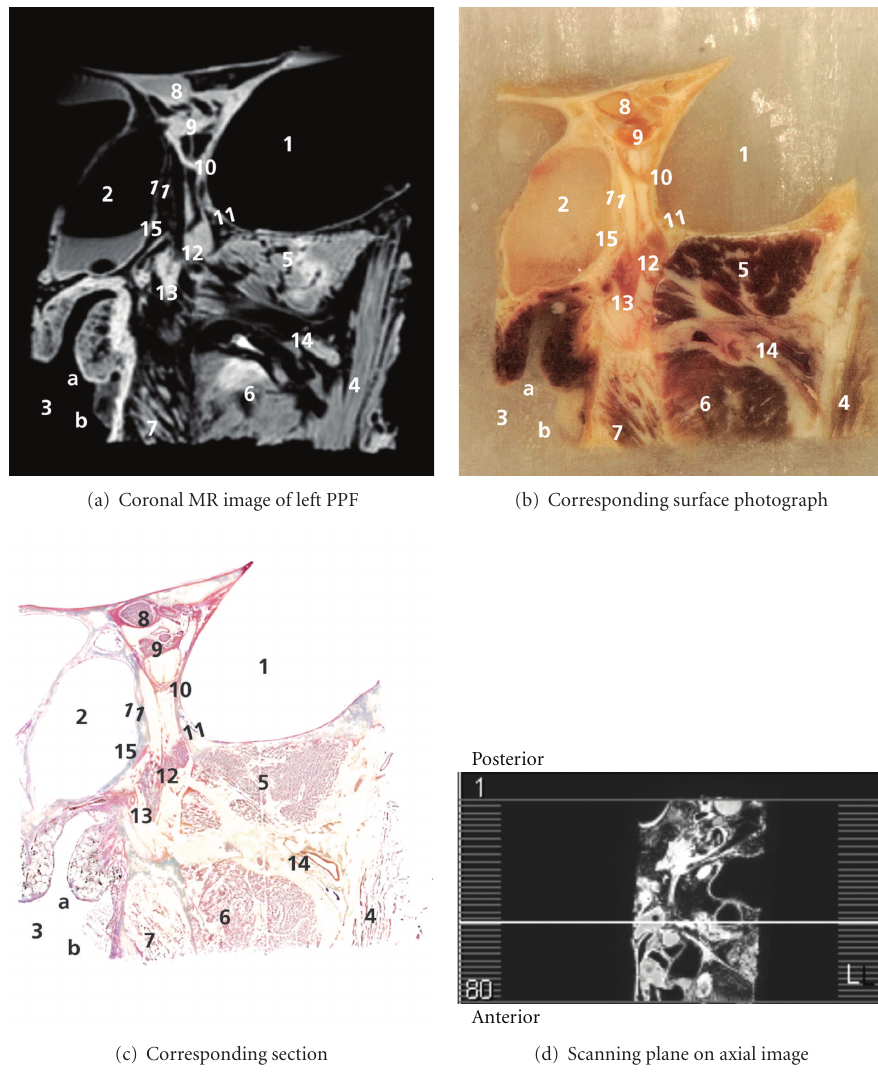
Figure 4: 1–12: see Figure 3. 13: origin of greater palatine nerve, 14: maxillary artery, and 15: pharyngeal